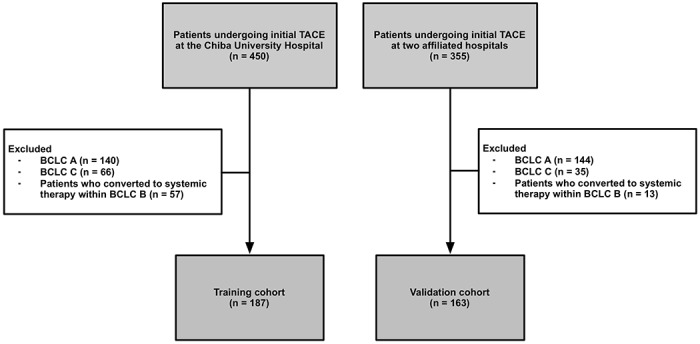
Flow chart of study.